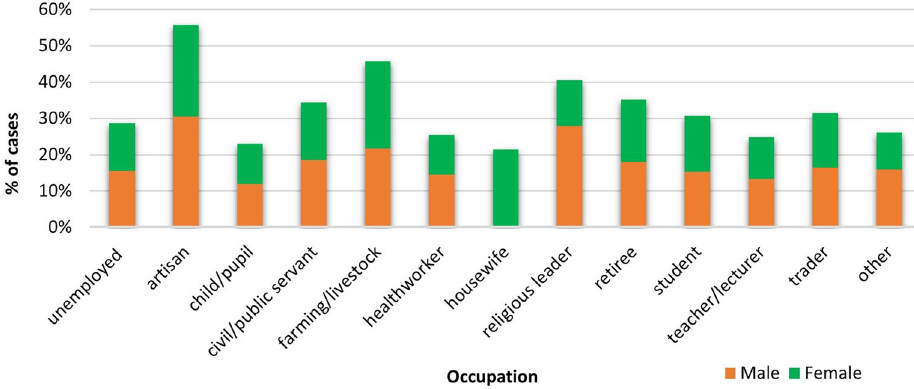
Figure 1. Sex-disaggregated LF positivity by occupational categories in Nigeria, 2018–2021.